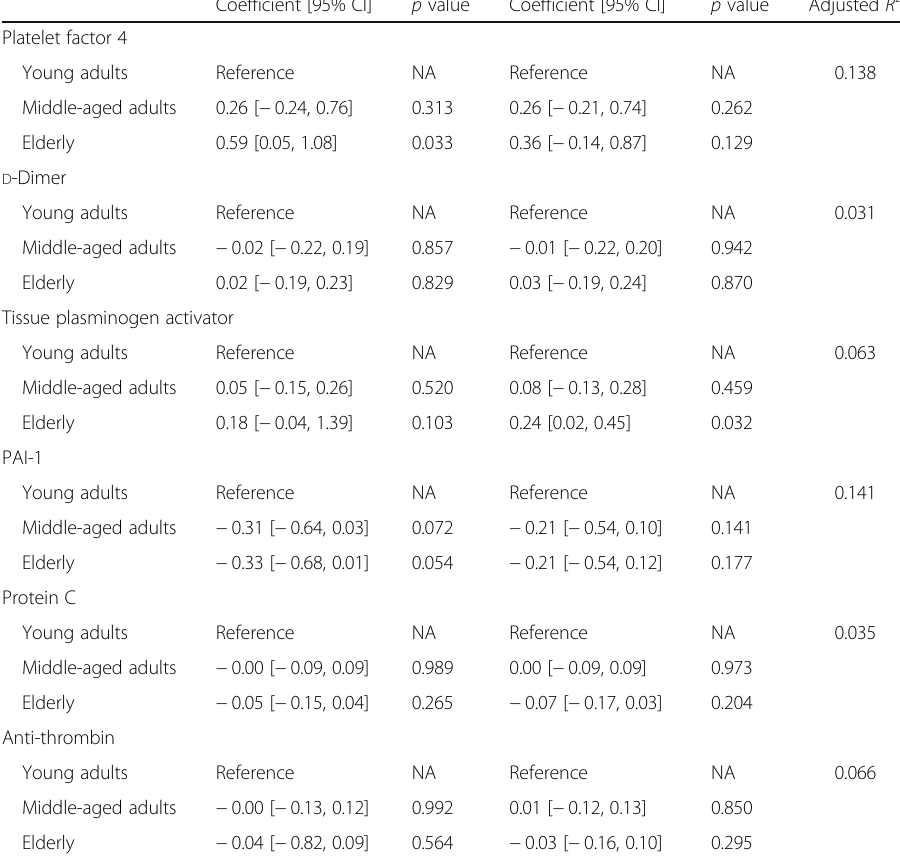
Table 5 Association between age and coagulation marker levels in ARDS patients (mediation step